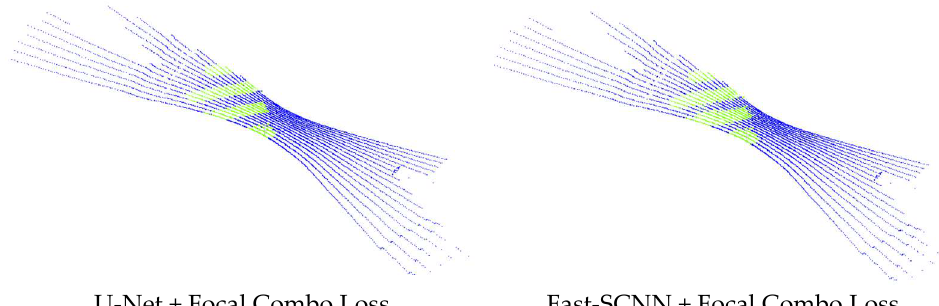
Figure 12. Sample generated classified sparse point cloud.